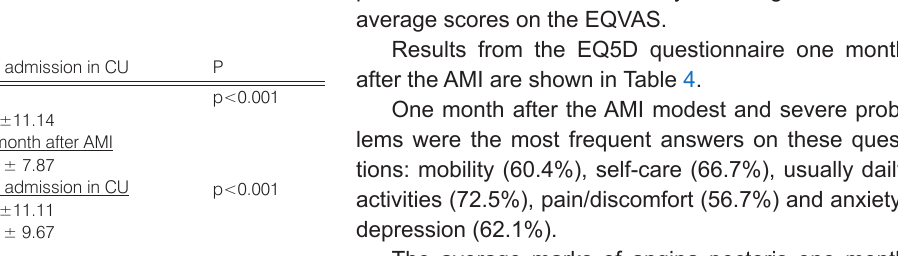
Table 2. The average scores on the EQVAS in patients Patients (n=160)